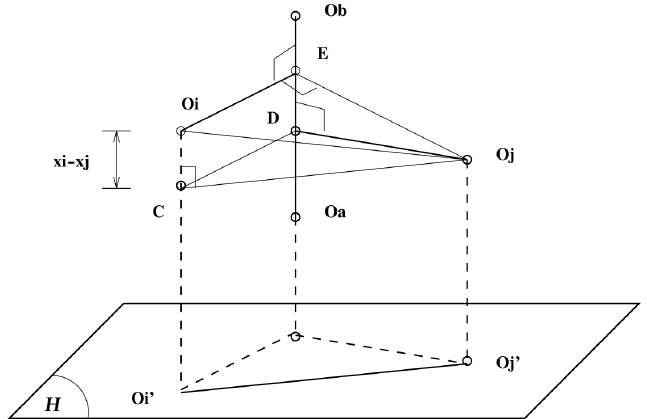
Figure 2. Projection of O i and O j into H hyperplane that is orthogonal to the previous one. The points O a and O b remain in the previous hyperplane and the triangles O a O i O b and O a O j O b , such as the respective points E and D , were considered to generate previous coordinates. Source: Faloutsos and Lin